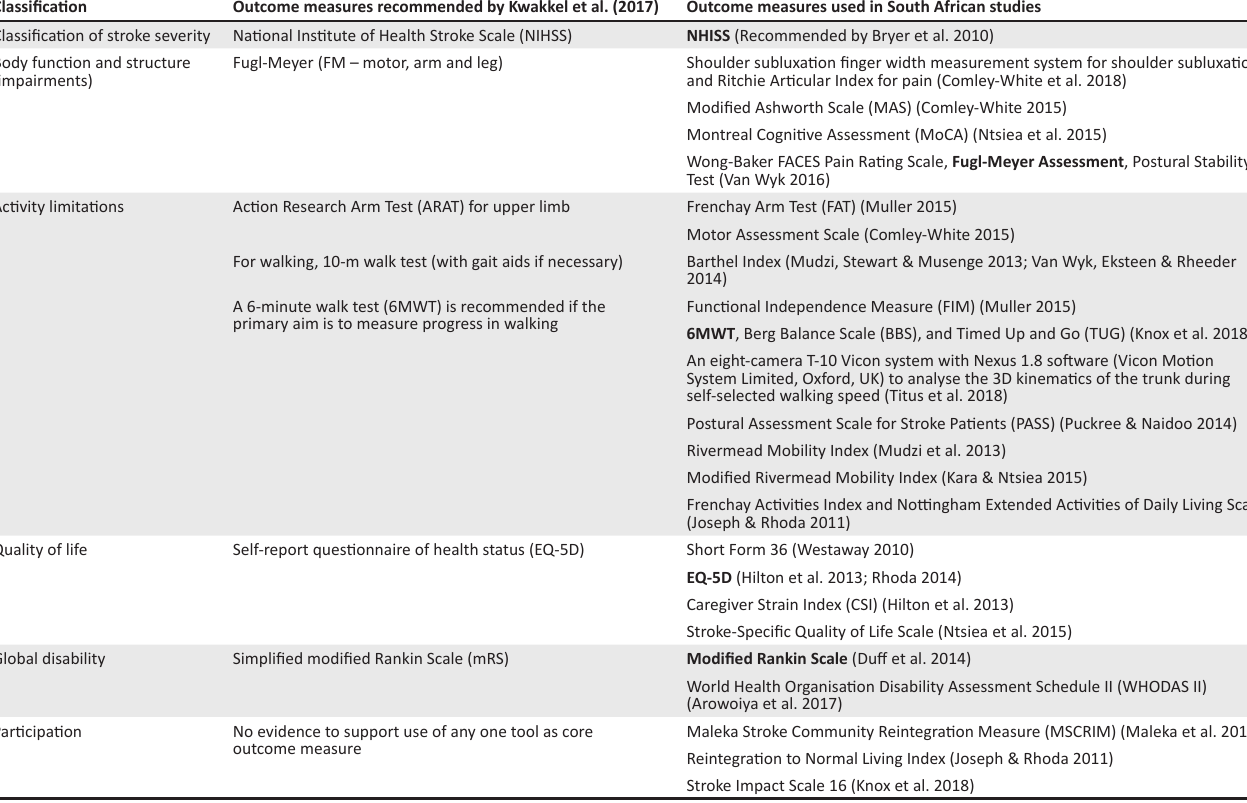
TABLE 1: Outcome measures used in stroke rehabilitation research in South Africa compared to core outcome measure recommended by Kwakkel et al. (2017). Classification Outcome measures recommended by Kwakkel et al. (2017) Outcome measures used in South African studies Classification of stroke severity National Institute of Health Stroke Scale